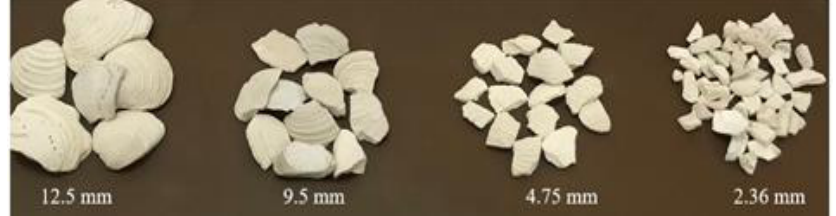
Figure 2. Florida washed shell particles of various sizes used in this study.